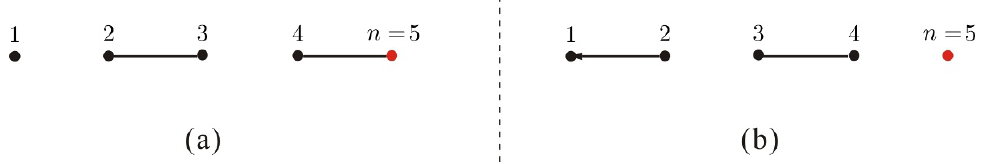
Figure 20 . Graphs (a) and (b) are typical skeletons (with three components) for graphs contribut- ing to T 1 and T 2 (see eq. (8.12)) with n = 5, respectively. Here the reference order is chosen